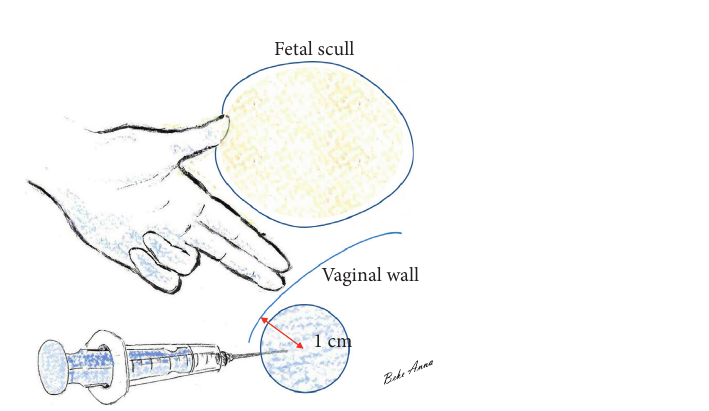
Figure 3: Proper protection of the skull by hand. The method is used in the second stage of labour. It is extremely important to protect the fetal skull in the cavity. Therefore the method can only be applied under the protection of the other hand. (1) Check and protect the skull with a gloved hand in the vagina. (2) Make sure the tip of the needle is about 1 cm deep from the vaginal wall—so the medicine you inject is not too